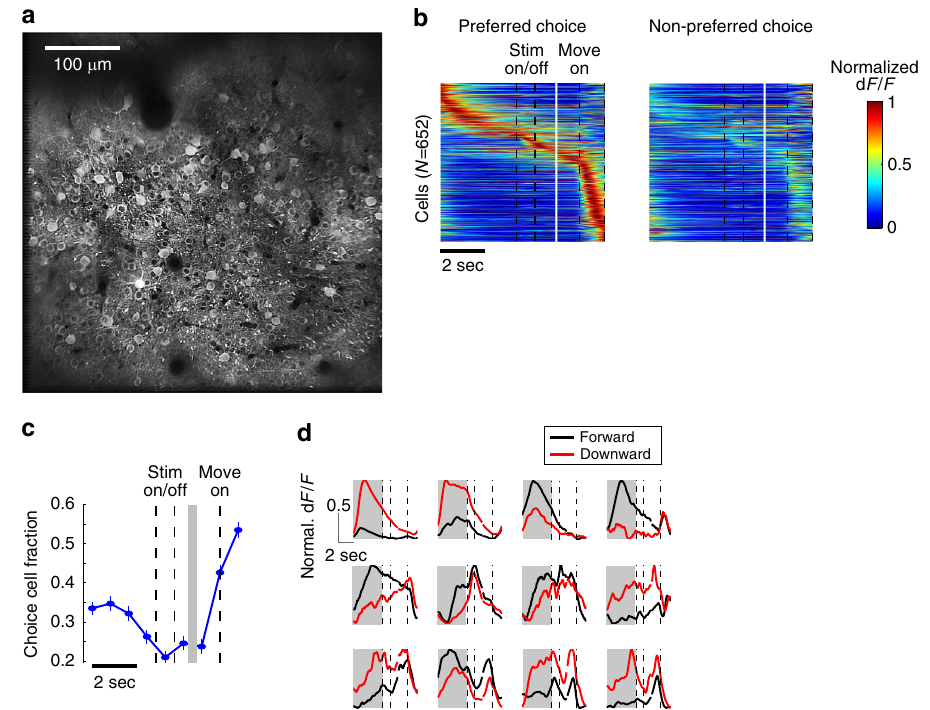
Fig. 3 Pre-stimulus activity during the inter-trial interval (ITI) in posterior parietal cortex (PPC) predicts the upcoming choice. a Two-photon calcium image of PPC neurons. b Trial-average activity of PPC choice-selective neurons for preferred vs. non-preferred choice trials. Each row represents the normalized activity of a single neuron sorted by its peak activity timing. c Fraction of neurons (mean ± s.e.m.) with signi fi cant choice selectivity ( p < 0.01 with Bonferroni correction) in 9 non-overlapping 1-s epochs out of all choice-selective neurons. d Example PPC neurons that are choice selective during the